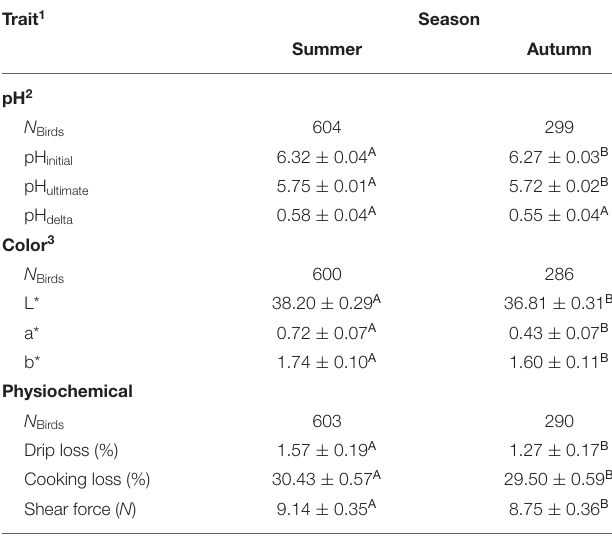
TABLE 6 | Differences in meat quality attributes in male turkeys ( N Birds = 817–895 depending on trait) between the summer (June–August) and autumn (September–November)